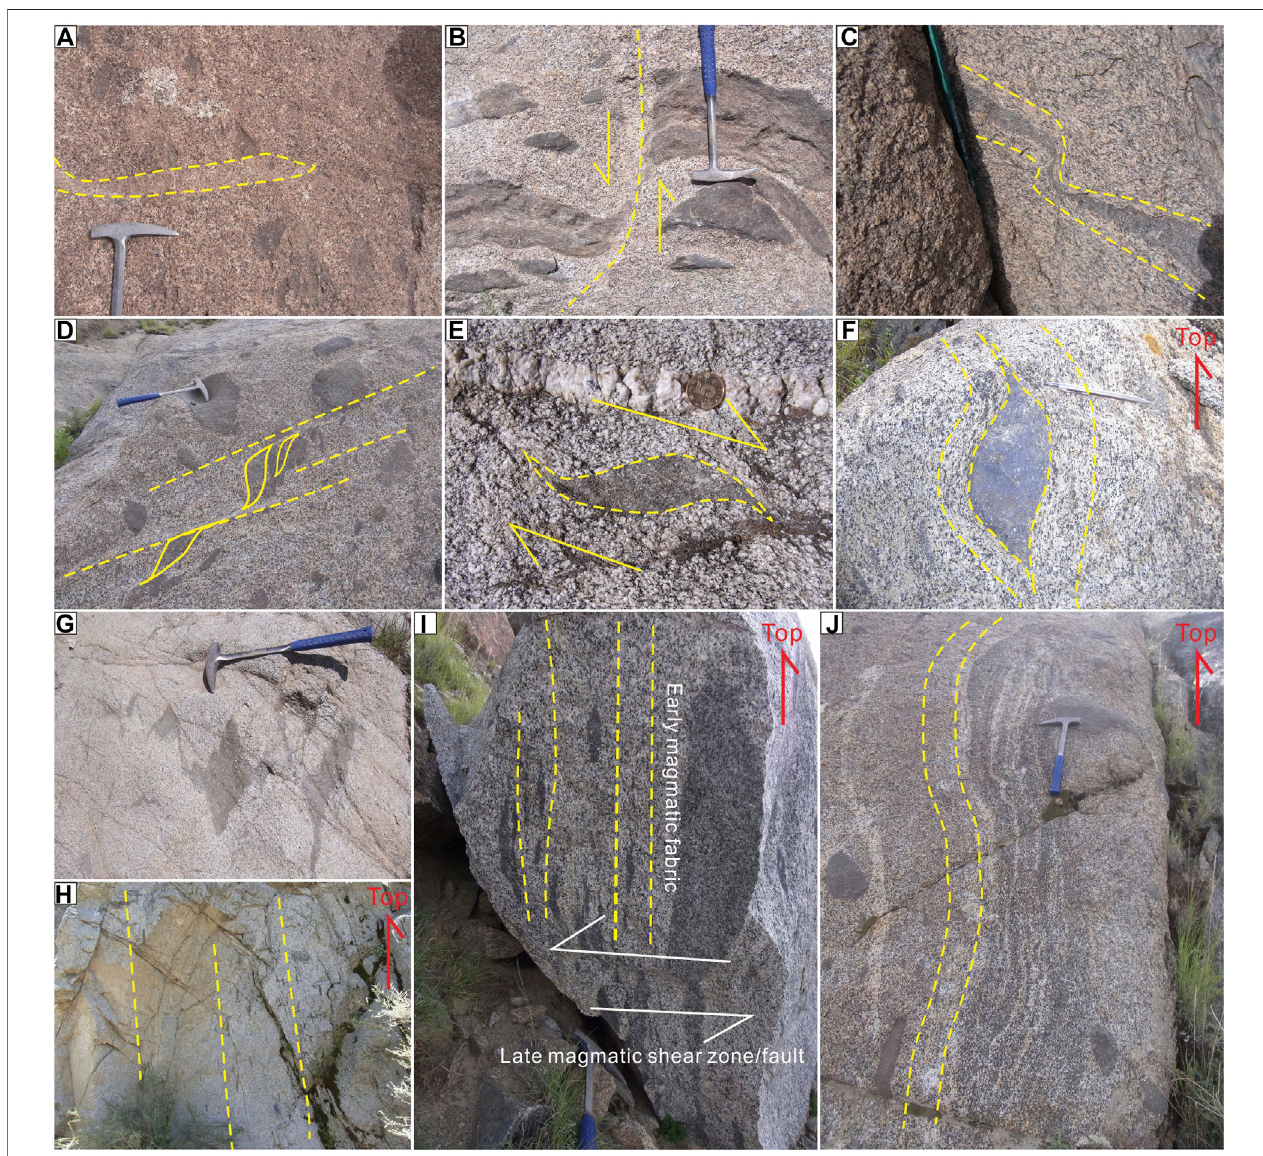
FIGURE 5 | Field photos showing the magmatic faults, folds, and schlieren structures. (A,B) Magmatic faultrepresented by a leucocratic zone. (C) Magmatic fold. (D – F) Magmatic faults, resembling ductile shear zones, with typical σ -type enclaves. (G) Magmatic folds, which have folded the enclave into a wave-like form. (H,I) Elongated enclaves oriented along the magmatic foliations. These foliations are cut by a second magmatic fabric. (J) An enclave that has been disrupted into schlieren- like ribbons by magmatic fl ow.